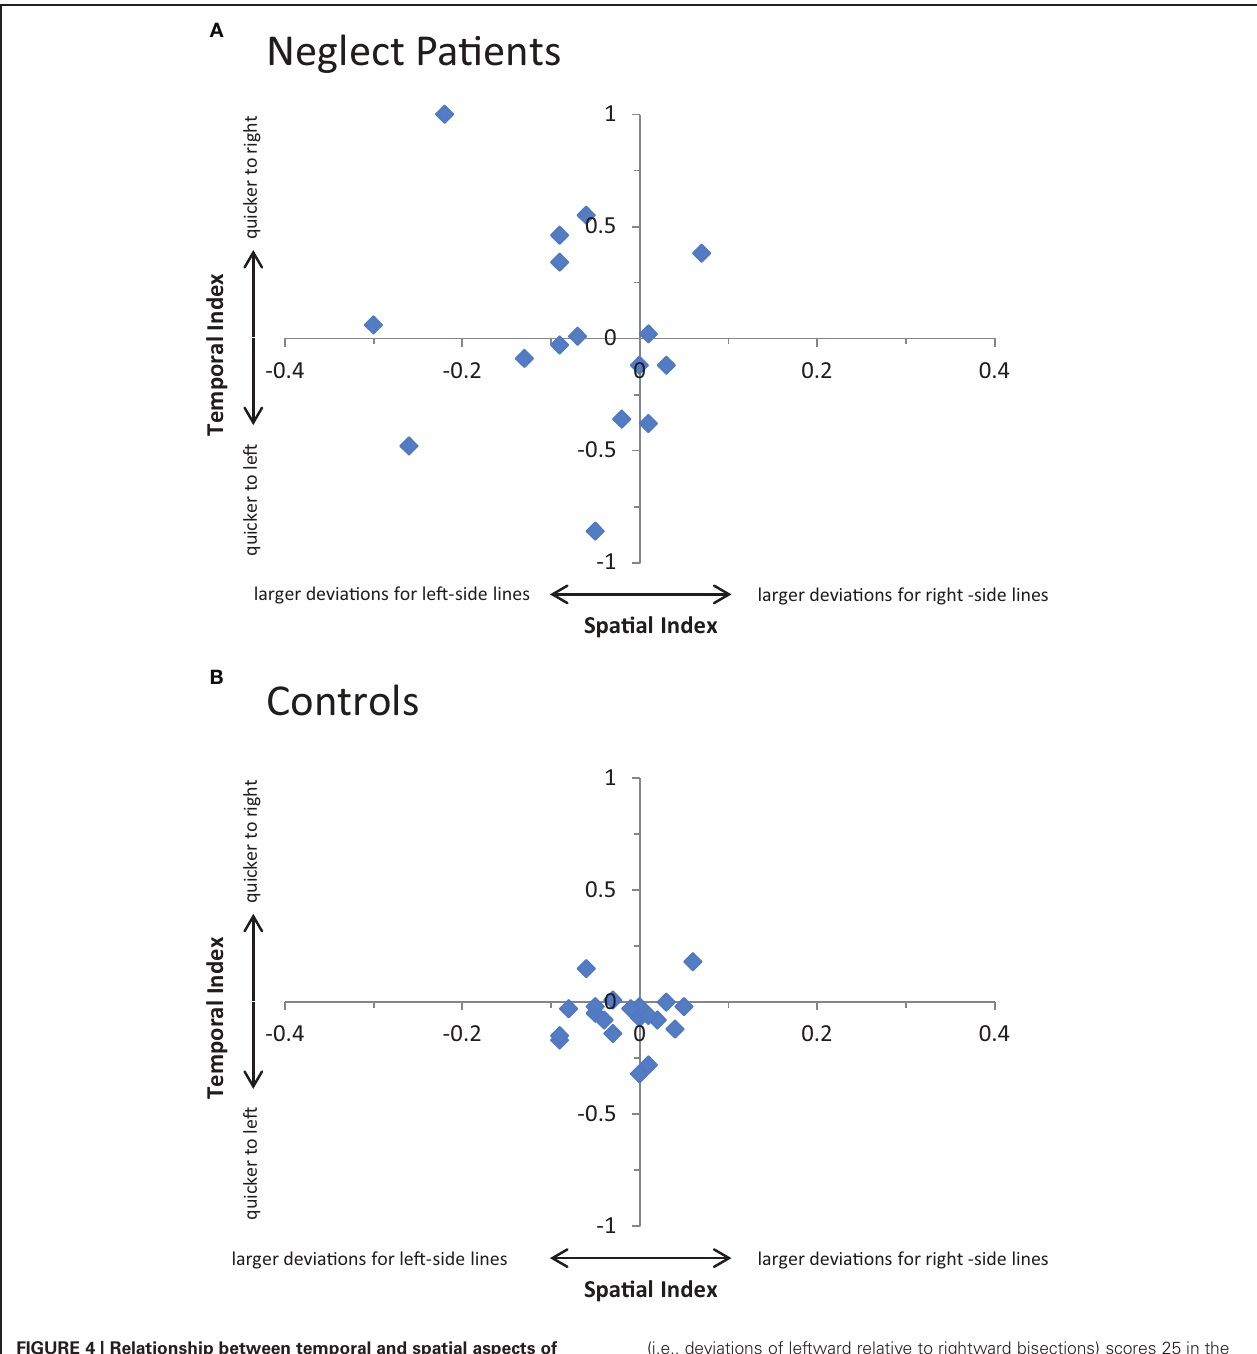
FIGURE 4 | Relationship between temporal and spatial aspects of neglect. (A) Shows 23 individual patients’ temporal (i.e., time required to perform leftward relative to rightward 24 bisections) and spatial